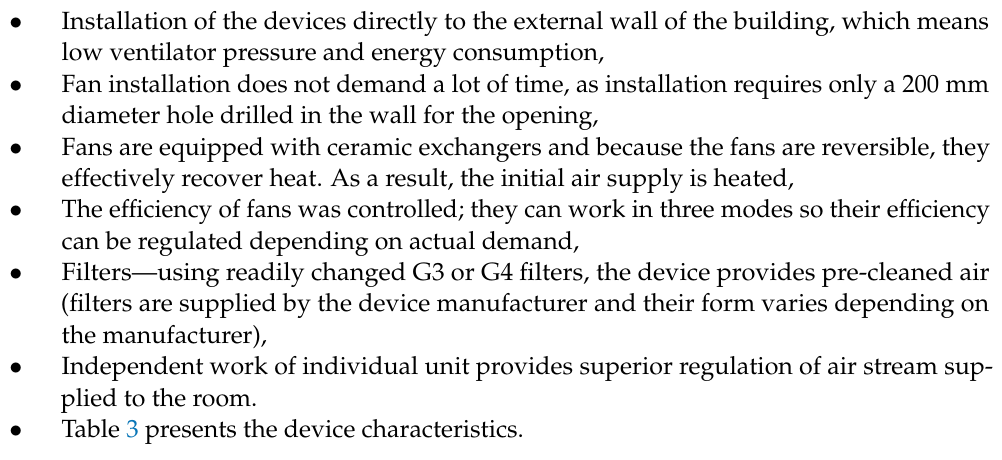
Table 3. Device characteristics